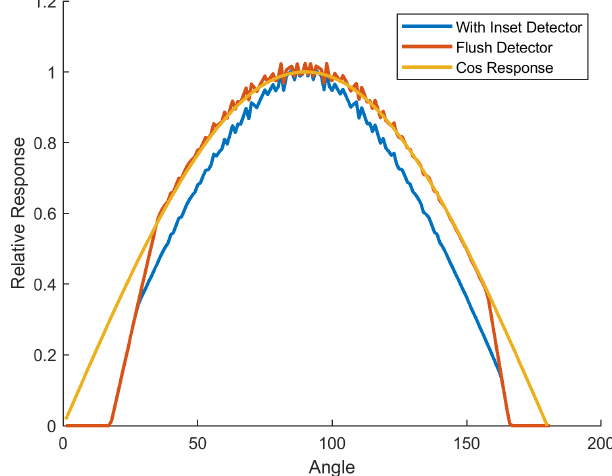
Figure 4. Relative response of the photodetector resulting from truncated scattering angles and a recessed photodetector. See the explanation of the different curves in the